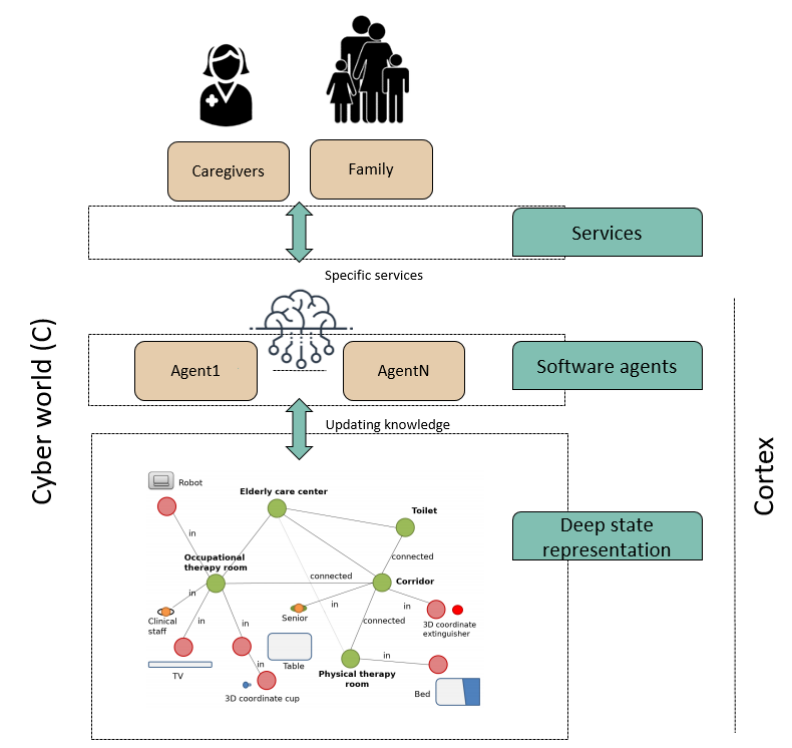
Figure 4. CPS-AAL architecture, which is built based on CORTEX cognitive